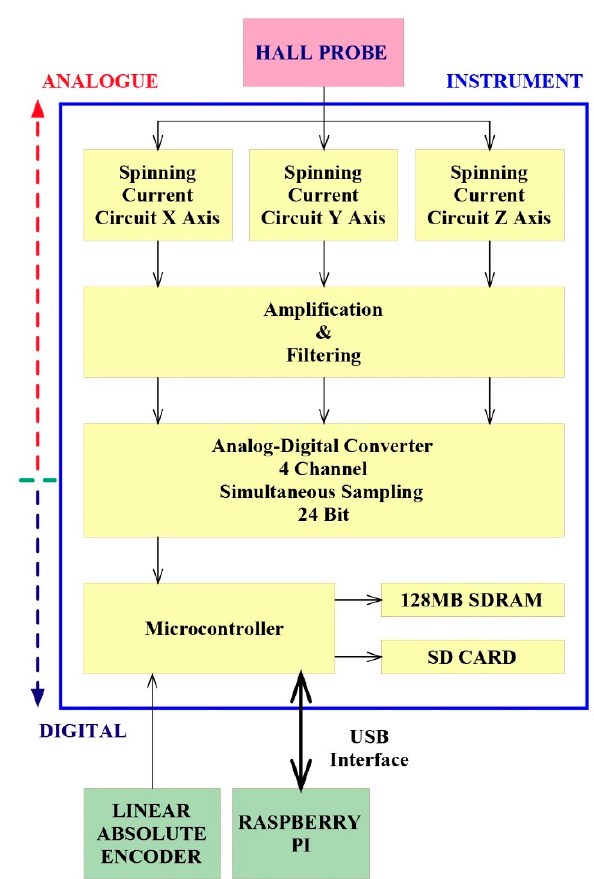
Figure 2. Architecture block diagram of the whole instrument showing the different functions in the analogue and digital sides.